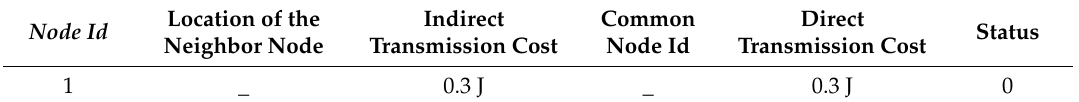
Figure 5. Node distribution with communication cost. Table 1. Vicinity table of node B1 after node 1 reply.